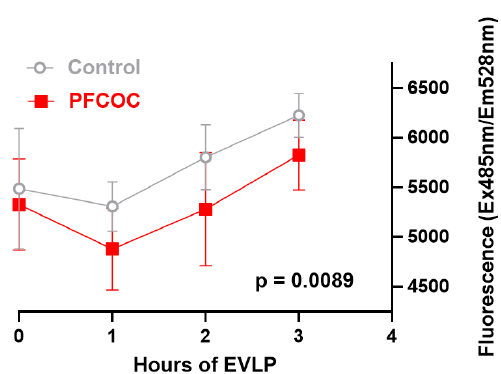
Figure 6. The flavin mononucleotide fluorescence readings of the perfusate taken hourly during EVLP is significantly higher in the control group compared to PFCOC group. Two-way analysis of variance (ANOVA) for repeated measures. Control: control group, PFCOC: perfluorocarbon-based oxygen carrier group.